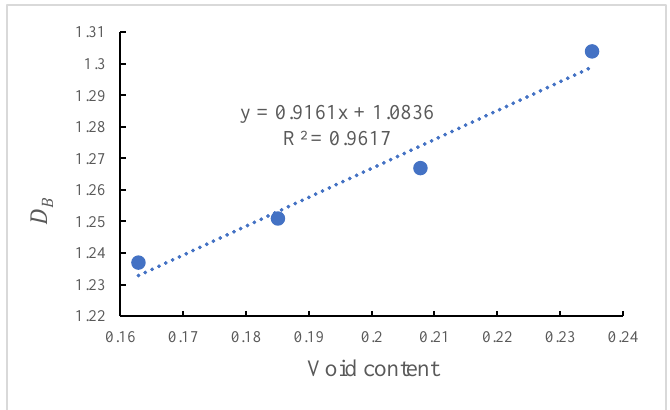
Figure 7. Relationship between 𝐷 𝐵 and the void content. As shown in Figure 8, the noise reduction impact improves as the fractal dimension grows, which results from a more complicated void structure, leading to a greater chance of acoustic wave reflections when the waves enter the interior void structure. Due to the increase in the fractal dimension, the interface between the acoustic waves and the void surface is increased, providing a larger friction area. This causes greater viscous loss gen- erated between the air and the void wall, resulting in a higher SAC.